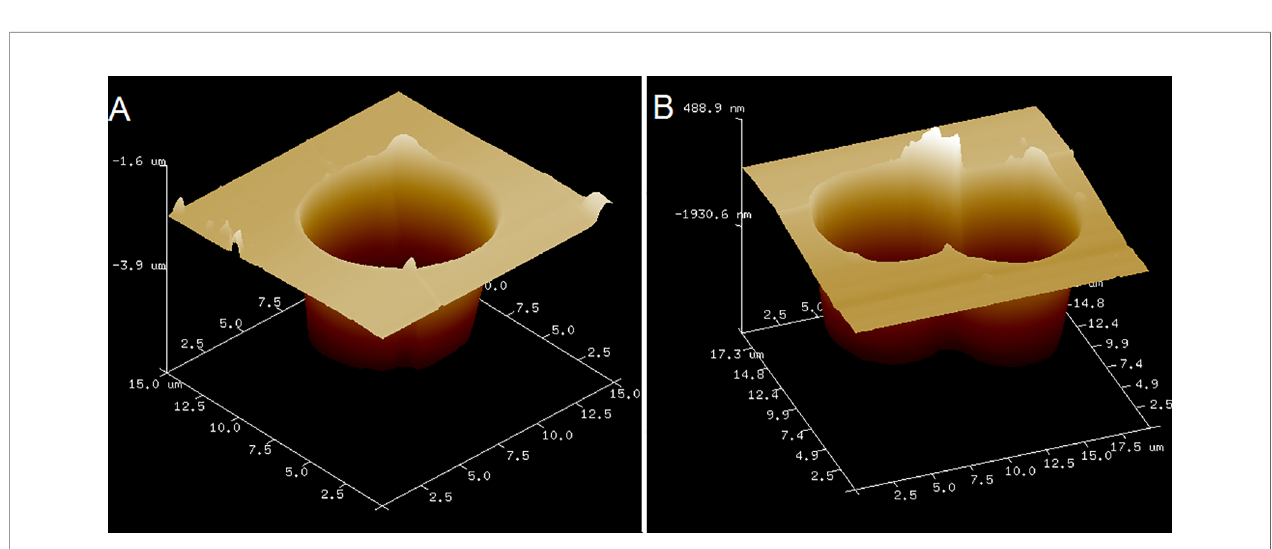
FIGURE 7 | Comparison of the cell surface elastic modulus of P. donghaiense. (A, C) The normal culture conditions. (B, D) The nitrogen limiting